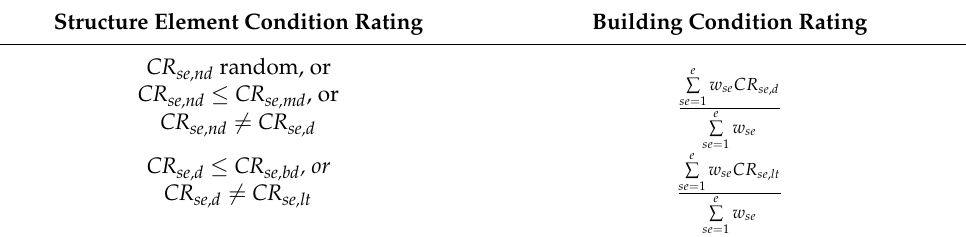
Table 5. Building condition rating